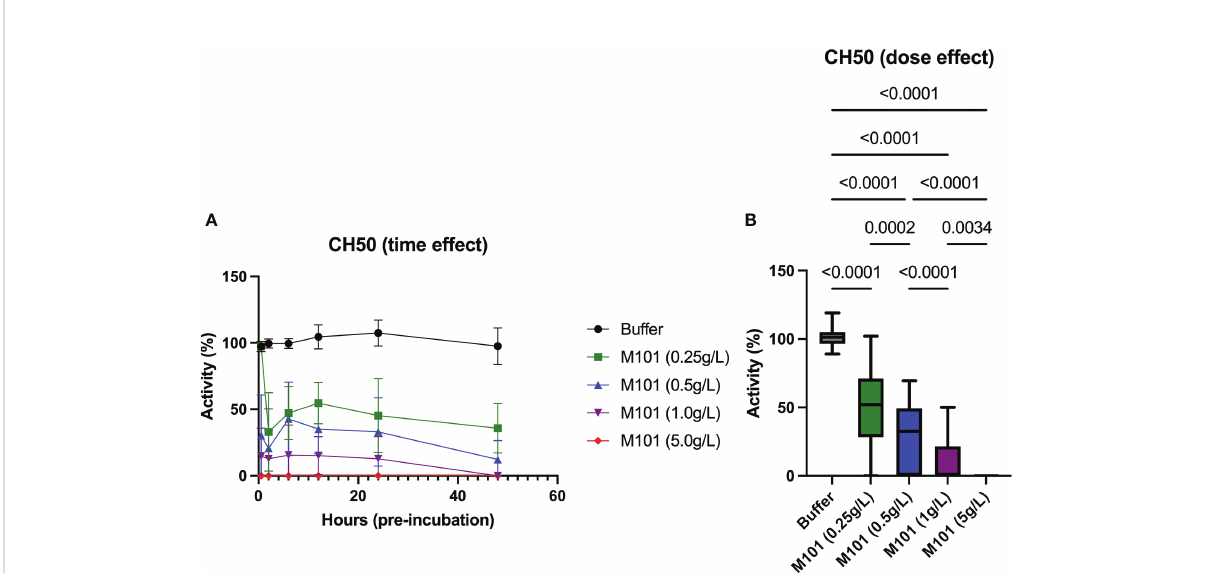
FIGURE 3 Dose and time-effect of M101 on the 50% classical complement pathway (CH50). EDTA whole blood from 6 healthy controls were pre- incubated with increasing amounts of M101 (buffer, 0.25 g/L, 0.5 g/L, 1 g/L and 5 g/L) during 30 min, 2h, 6h, 12h, 24h and 48h before being centrifuged and EDTA-plasma frozen (-80°C). After that, CH50 activity was evaluated by hemolytic activity using IgG-coated sheep blood cells. (A) M101 pre-incubation time effect. (B) M101 dose effect, for each concentration all time points are indicated and results are expressed as box plots of interquartile range. P values are indicated when signi fi cant